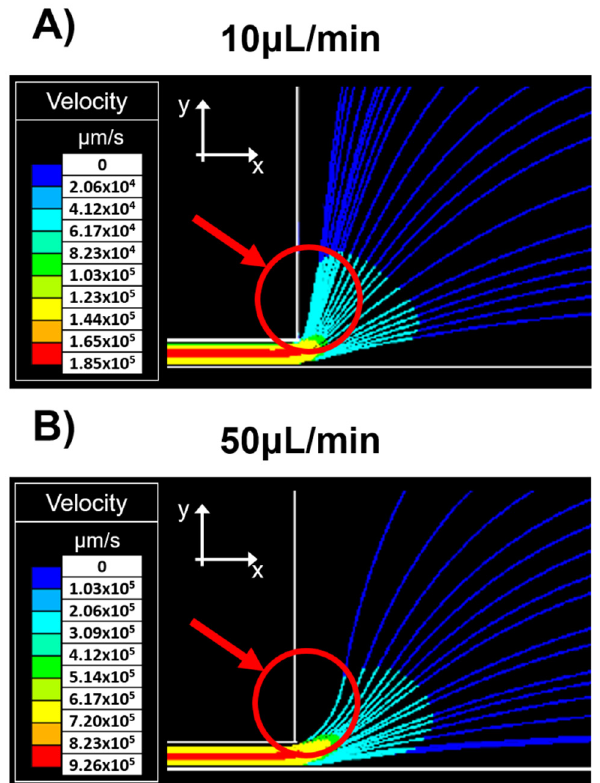
Figure 4. Simulation of tracer particles at the outlet of the narrow channel. ( A ) 10 μ L/min and ( B ) 50 μ L/min. The color gradient represents particle velocity.